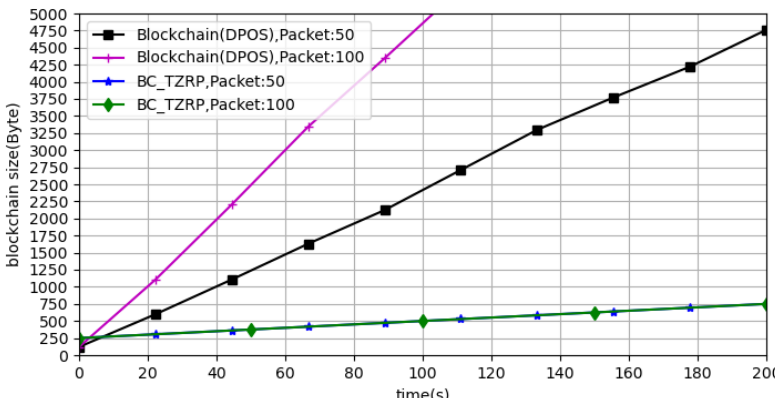
Figure 7. Blockchain Storage Growth